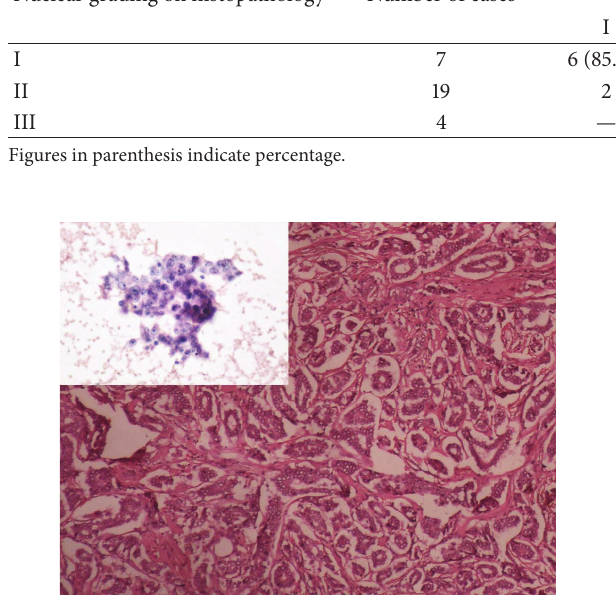
Figure 1: Infiltrating ductal carcinoma histological grade I— predominantly tubular differentiation, mild variability in nuclear size and shape, and uniformly dispersed nuclear chromatin. Inset (Robinson’s cytological grade I): loosely cohesive cluster of monomorphic ductal epithelial cells exhibiting mild nucleomegaly (1-2 times the size of erythrocytes), smooth nuclear margins with small nucleoli (H&E, × 100; inset: PAP, × 400).